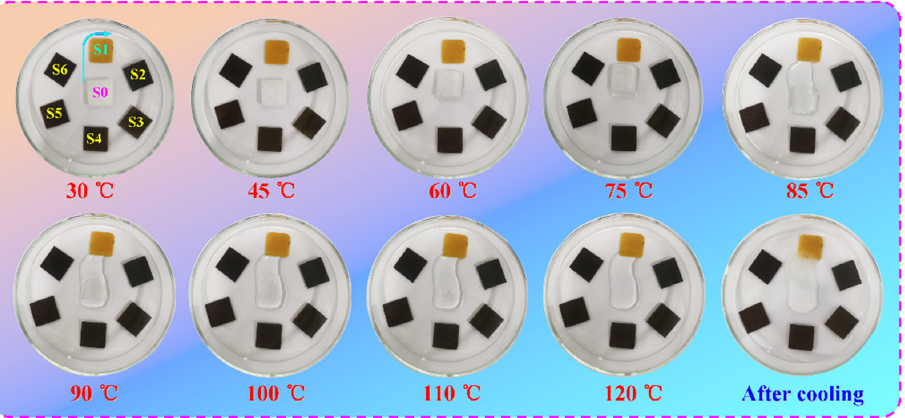
Figure 14. Digital photographs of (S0) pure PEG, (S1) PI aerogel/PEG composite film, and PI/graphene/Fe 3 O 4 aerogel/PEG composite films containing 5 wt% graphene nanosheets and (S2) 0, (S3) 2, (S4) 4, (S5) 6 and (S6) 8 wt% Fe 3 O 4 nanosheets recorded during the isothermal heating process.